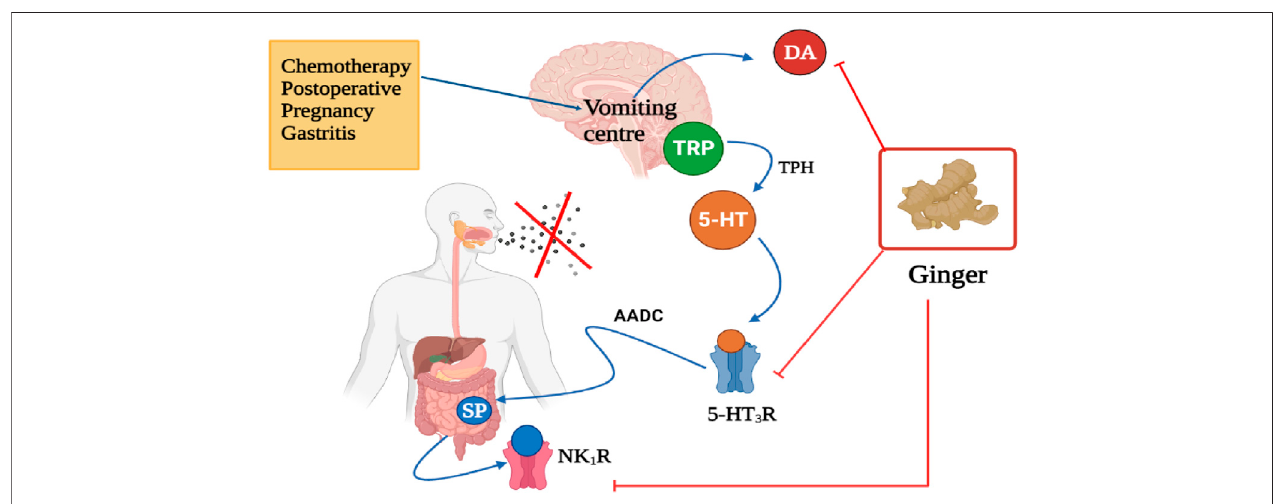
FIGURE 7 | Anti-emetic effect of ginger, targets, and mode of action. TRP, Tryptophan; 5-HT, 5-Hydroxytrptamine (serotonin); 5-HT 3 R, 5-Hydroxytryptamine 3 receptor; AADC, Aromatic L-amino acid decarboxylase; SP, Substance P; NK 1 R, Neurokinin 1 receptor; DA, Dopamine. X represent ceased vomiting. Figure was created using BioRender.com by the